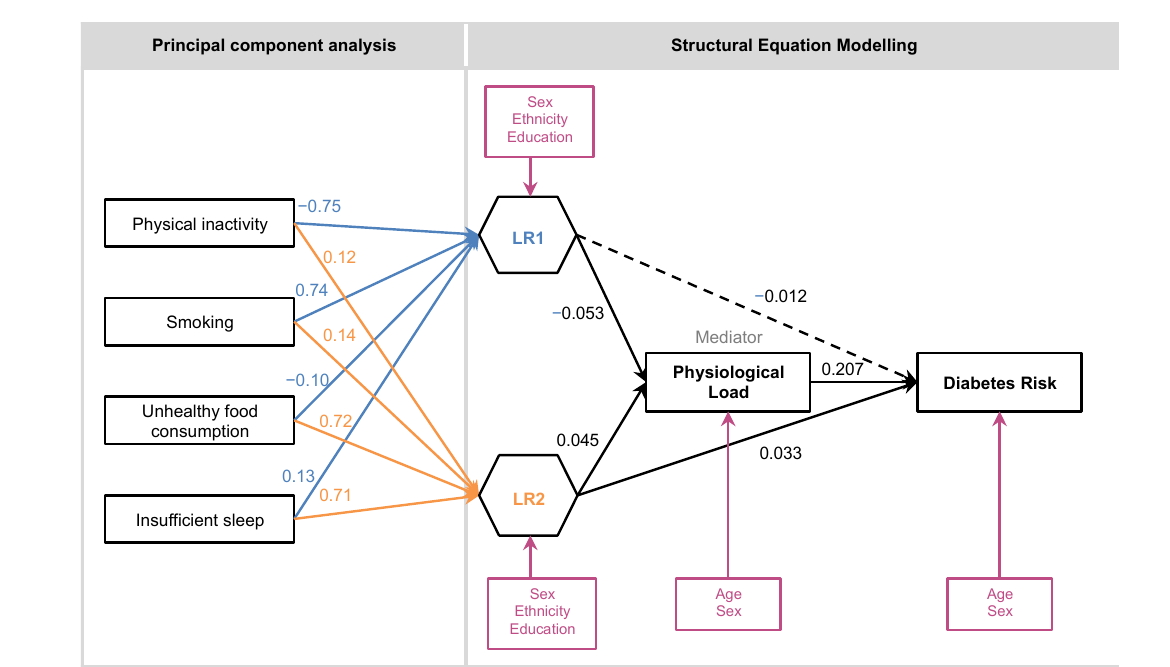
Figure 1. Illustration of the hypothesized pathways between Lifestyle Risk, Physiological Load and Diabetes Risk. Lifestyle Risk has a positive but indirect effect on Diabetes Risk through the mediator of Physiological Load. Note: Straight line with one arrowhead denotes positive and di- rect effect; dashed line with one arrowhead denotes positive but indirect effect.